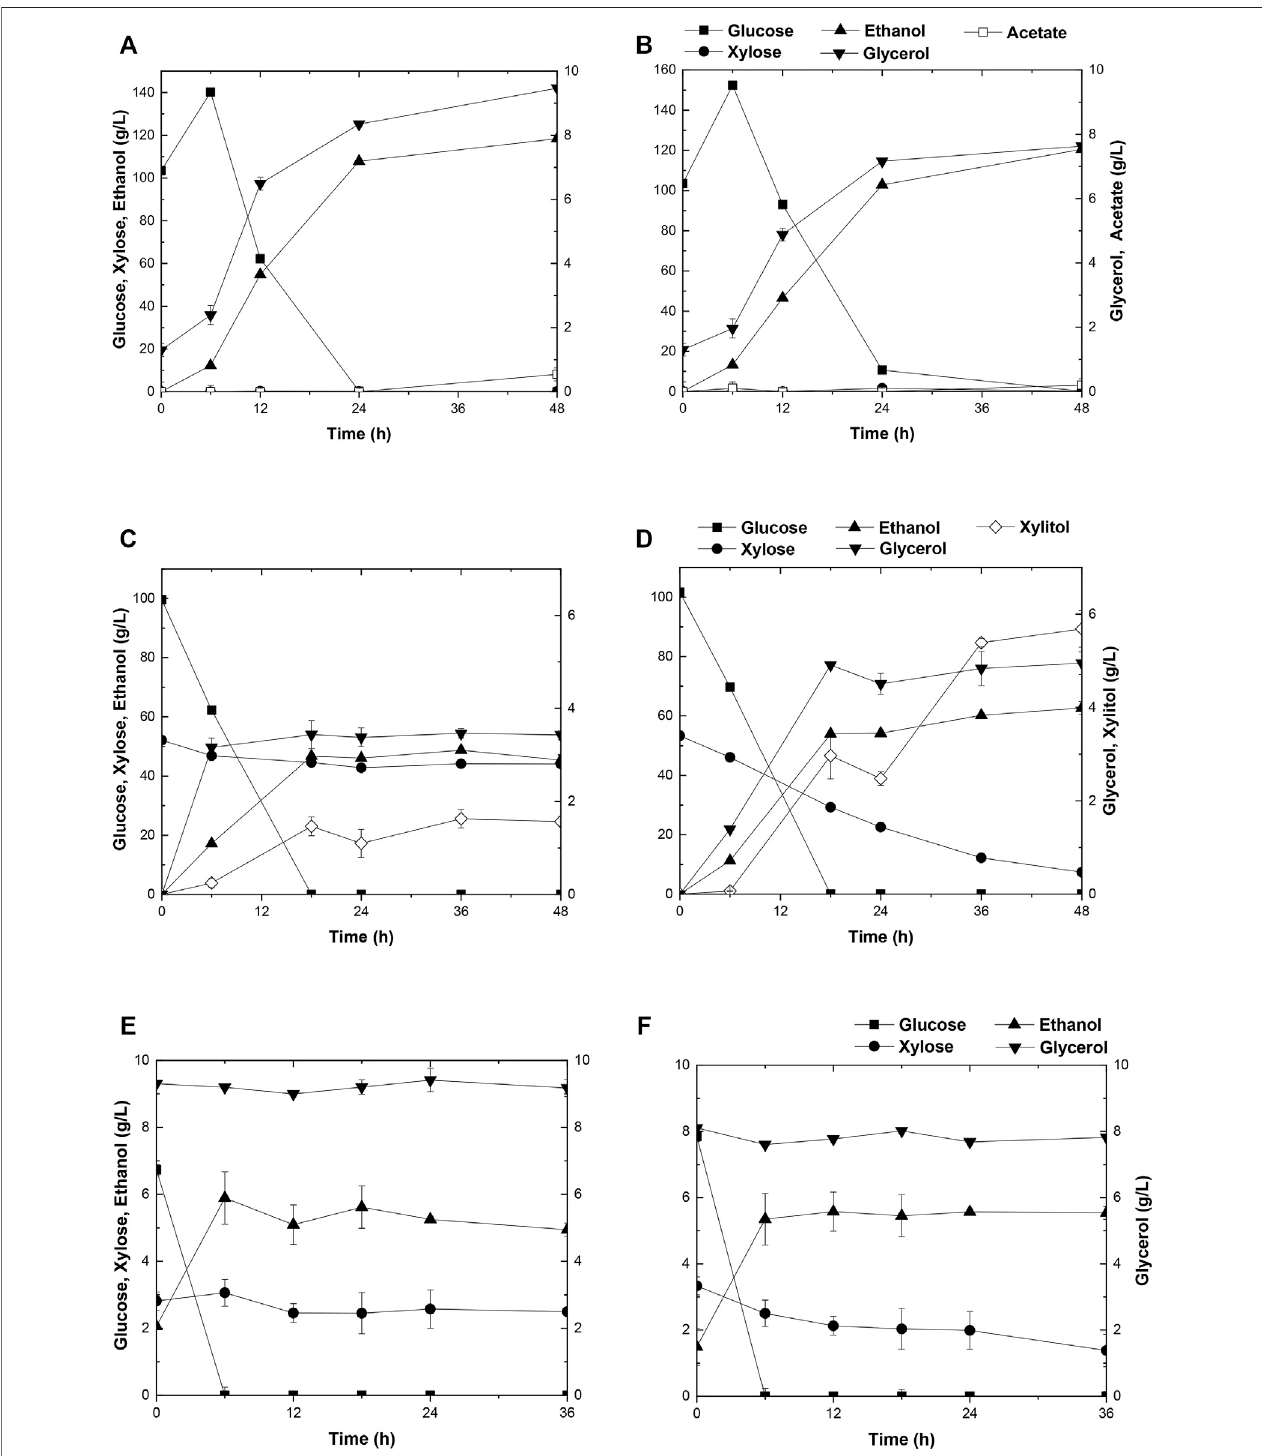
FIGURE 5 | Time-dependent fermentation of Angel and A31Z. Fermentation pro fi le of Angel (A) and A31Z (B) in corn starch medium. The fermentation pro fi le of Angel (C) and A31Z (D) in mixed sugar medium of 100 g/L glucose and 50 g/L xylose. The fermentation pro fi le of Angel (E) and A31Z (F) from DDGS.